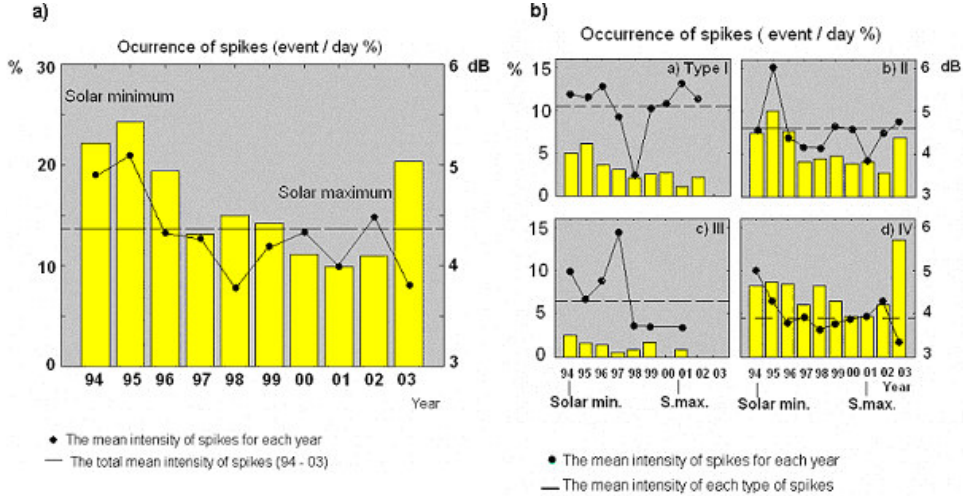
Fig. 4. (a) Yearly variations of spike events in the IRIS FoV during 1994–2003. Bars are yearly occurrence (event/day) of spike events and dots are the mean intensity of spikes for each year. Dashed line (- - -) is the mean intensity of all spike events (4.4dB). Year 1994 is start of solar minimum and year 2001 is solar maximum. (b) Yearly variations for each type of spike events during 1994-2003. Dashed lines (- - -) are the mean intensity of each type of